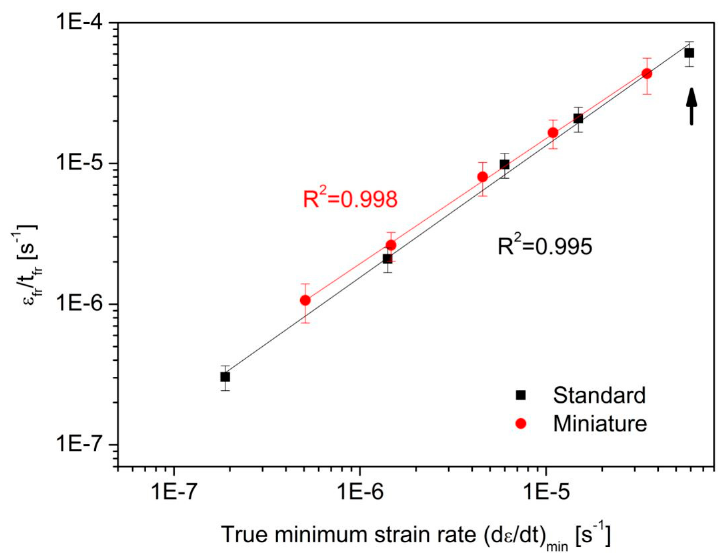
Figure 9. Illustration of the modified Monkman–Grant equation.